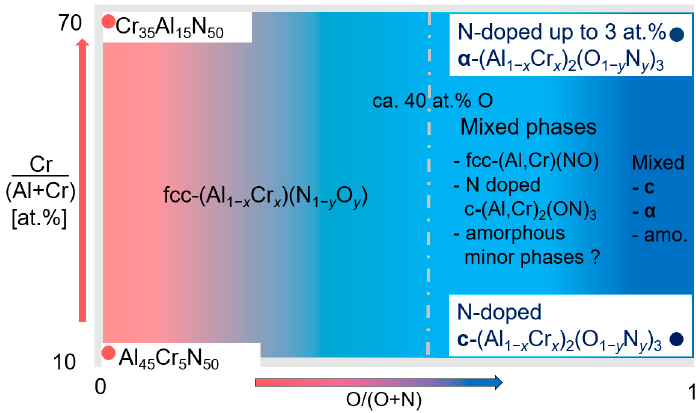
Figure 23. Schematic representation of phase evolution in the (AlCr)NO system dependent on Cr/(Al + Cr) and O/(O + N) at a deposition temperature in the range of about 500–600 ◦ C, c = cubic structure, amo. = amorphous